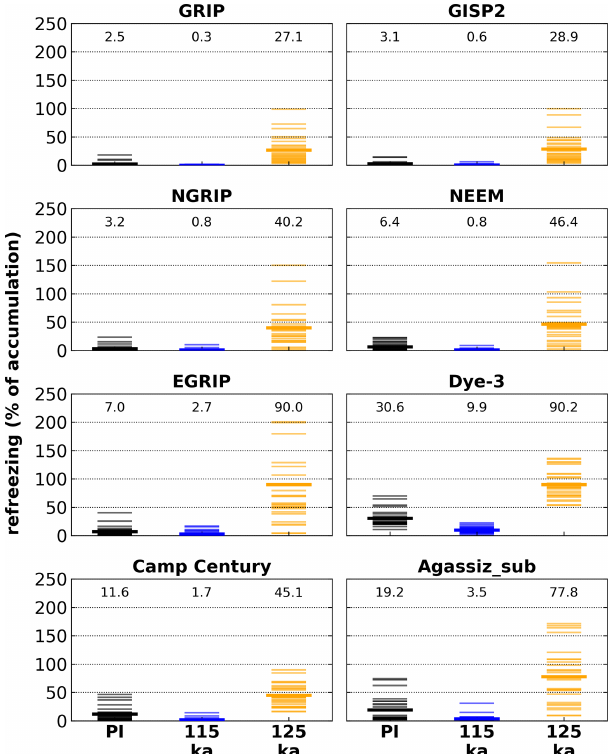
Figure 4. Annual melt days at Greenland ice core locations de- rived from satellite data and simulated by the MAR climate model. Observations in the first three columns from the left are compared with simulations in the fourth and fifth column. Columns from the left: (1) passive microwave data from MEaSUREs (1979 to 2012); (2) the same data as in (1) but with a different processing (T19H melt ; Fettweis et al., 2011) (1979 to 2010); (3) the MEaSUREs dataset ex- cluding the extreme melt year 2012 (1979 to 2010); (4) simulated melt for pre-industrial (PI); and (5) 125ka conditions. Individual model years (thin lines) and the ensemble means (bold lines, numer- ical values on top of columns) are shown. For Agassiz, simulation results for the substitute location are shown, as discussed in Sect. 2.